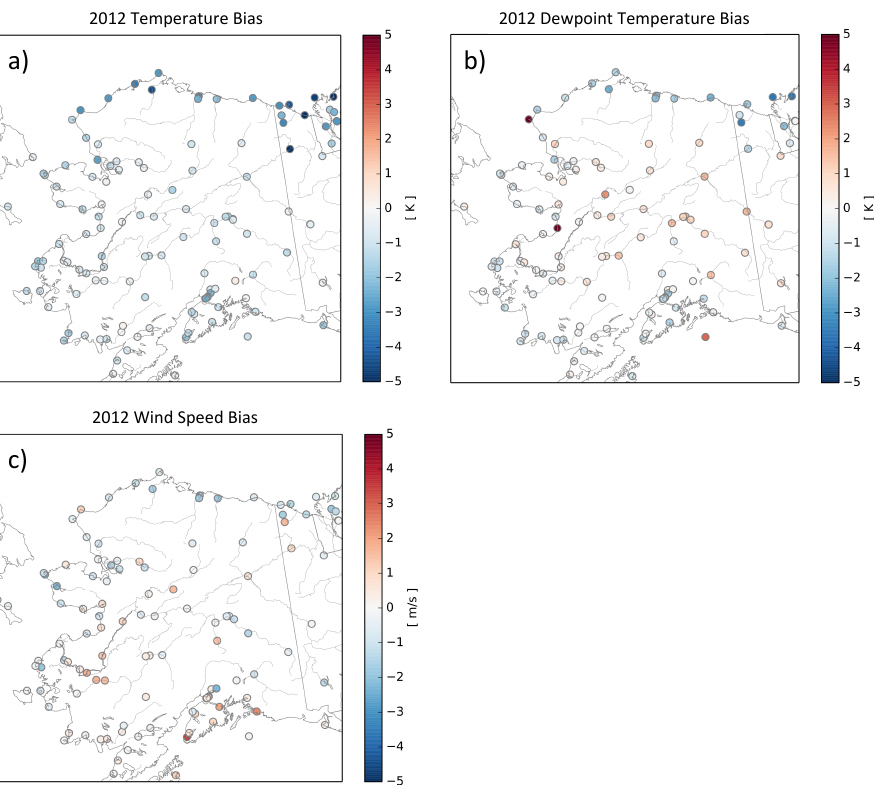
Figure 6. Spatial distribution of WRF v3.4.1 bias in the innermost domain (3.3km grid spacing) for the entire 2012 campaign for (a) temperature (K), (b) dewpoint temperature (K), and (c) wind speed (ms − 1